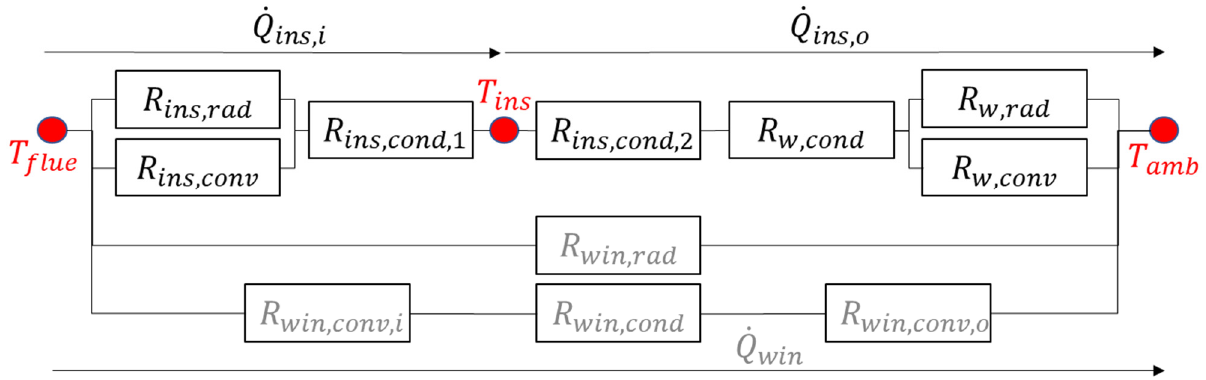
Figure 7. Thermal resistance diagram of the stove wall and window. In the simulation tool, the CO emissions are simulated using empirical values from